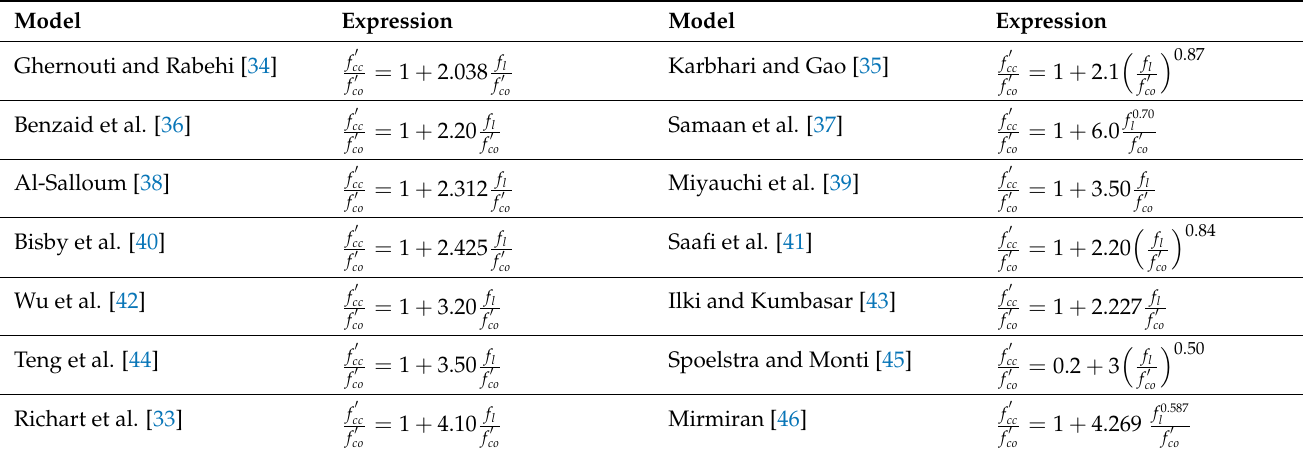
Table 4. Existing analytical models.